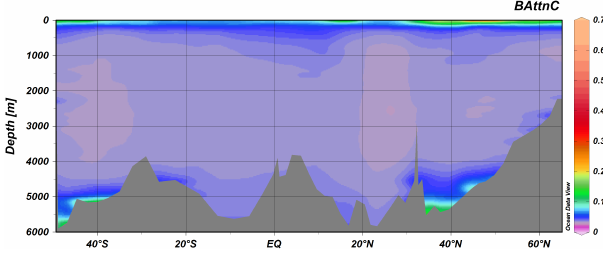
Figure 2. Beam attenuation coefficient, a measure of the amount of particles (e.g. Behrenfeld et al., 2006). Courtesy of Micha Rijken-